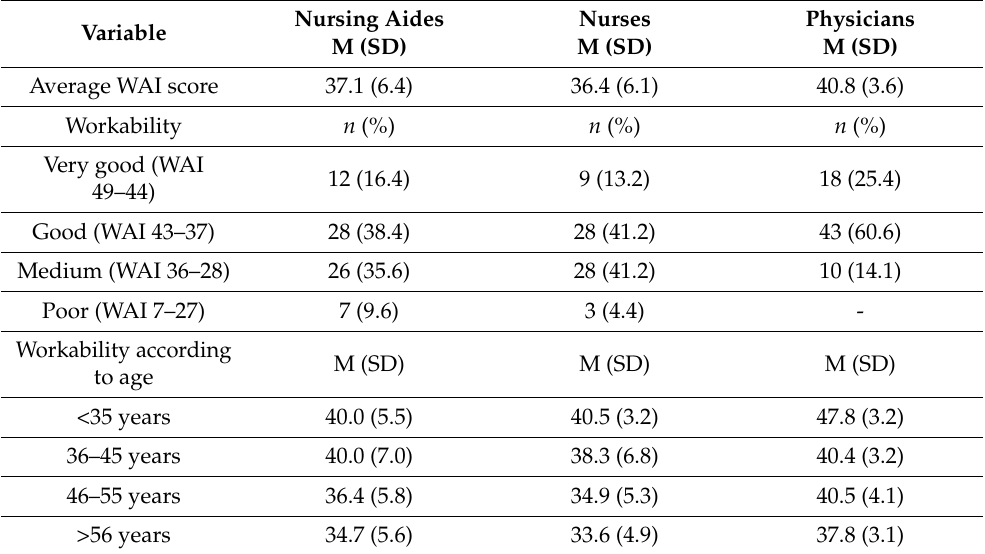
Table 3. Workability among healthcare